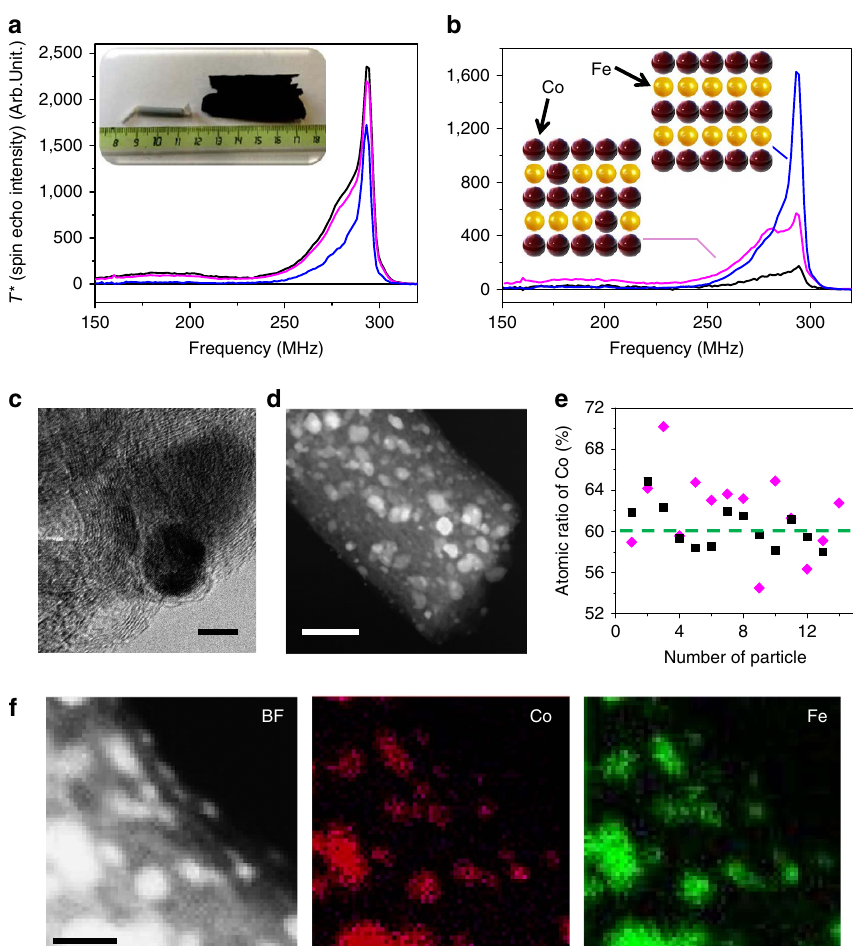
Figure 5 | Co-Fe alloyed nanoparticles embedded in the carbon fibres. ( a ) The 59 Co zero field FNR spectra recorded at 2 (black), 4.2 (magenta) and 77K (blue). The inset optical photo shows the tested sample in the setup (left) and a totally expended sample (right) with the same mass ( B 100mg, with size around 3cm by 5cm). ( b ) TDFNR spectra: in black spectrum measured at 2K minus spectrum measured at 4.2K; in magenta spectrum at 4.2K minus spectrum at 77K; in blue spectrum at 77K. The inset structure models display the B2 ordered Co and Fe atoms (blue spectrum) and the same ordered structure but with an excess of Co atoms (magenta and black spectra). ( c ) High-resolution TEM image of typical Co-Fe alloyed nanoparticles embedded in the porous carbon fibres. ( d ) Representative HAADF-STEM image of various size particles embedded in carbon fibres, and ( e ) relative Co and Fe atomic concentration in big (30 ± 3nm, black) and small (10 ± 3nm, magenta) alloyed nanoparticles measured by EDS mapping. ( f ) Relative map with Co in red and Fe in green showing the Co and Fe elements dispersed in different size of alloyed nanoparticles. The scale bars in c , d and f are 5, 100 and 30nm,